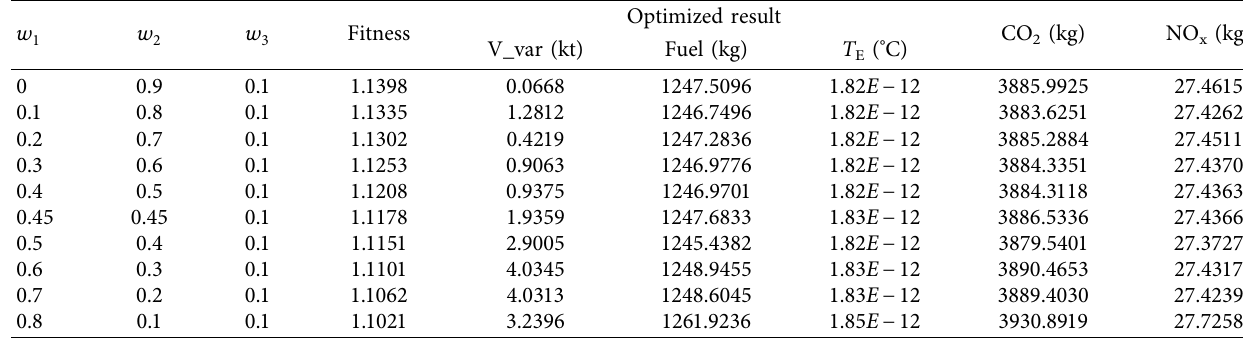
Figure 7: Optimization results with change of w Table 4: w � 0 . 1 optimized result. 3